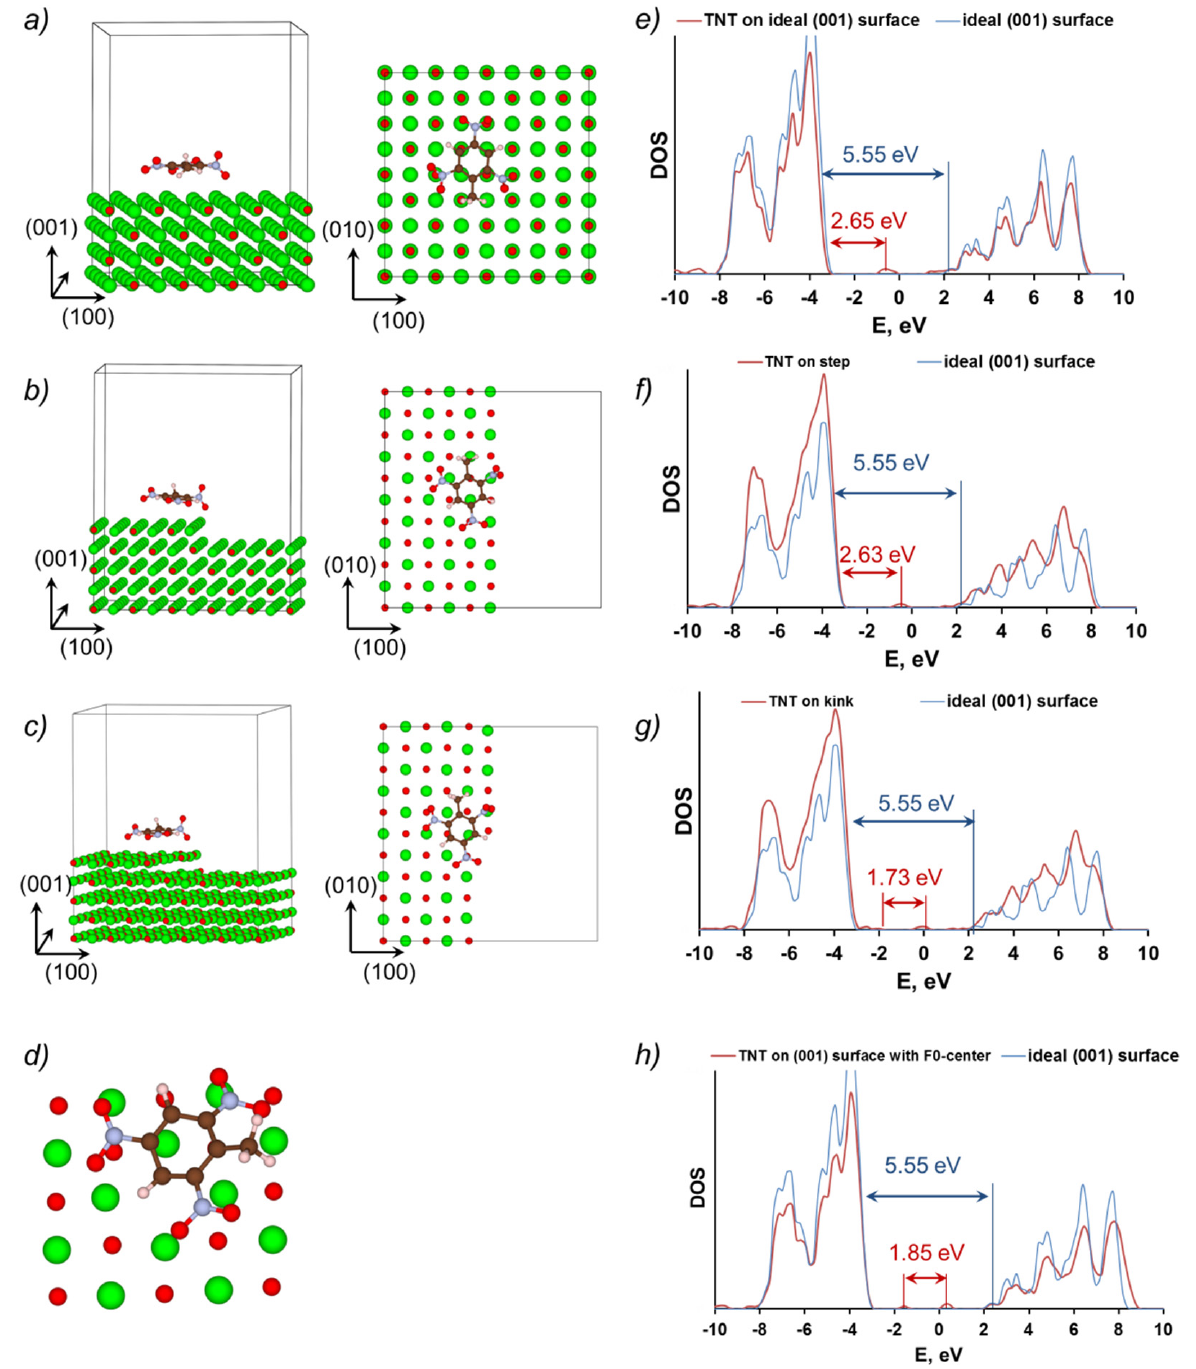
Figure 5. Schematics of the supercells that consist of a TNT molecule adsorbed at: ( a ) a pristine (001) MgO surface; ( b ) a monoatomic step at (001) MgO surface; ( c ) a kink at (001) MgO surface, ( d ) an F 0 -center at (001) MgO surface. Figure also shows total DOS for same configurations: ( e ) a pristine (001) MgO surface; ( f ) a monoatomic step at (001) MgO surface; ( g ) a kink at (001) MgO surface; ( h ) an F 0 -center at (001) MgO surface. Mg—green, O—in red, C—in brown, N—in blue, H—in white.